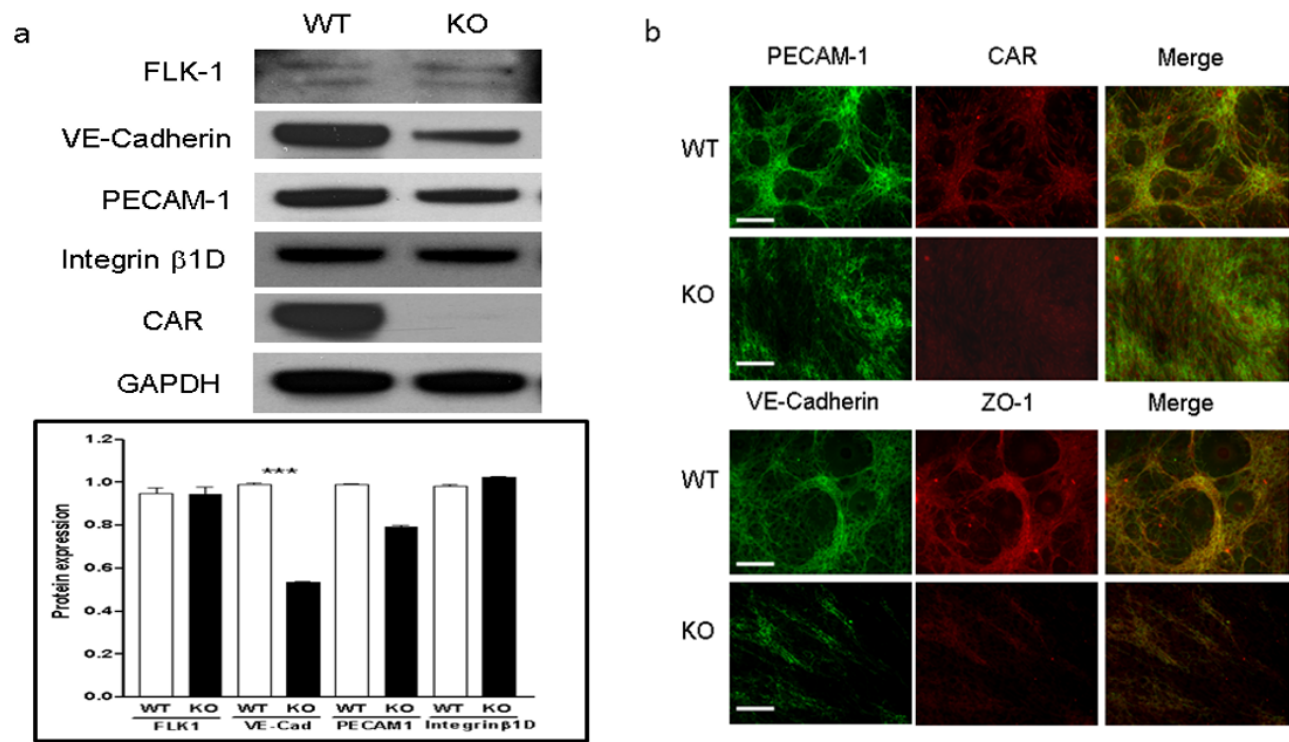
Figure 6. CAR deletion disrupts endothelial cell VE-cadherin and PECAM-1 expression. ( a ). Endothelial cells were isolated from the livers of WT and KO (with deleted CAR) mice. Cell extracts were subjected to Western blot analysis using the indicated antibodies. ( b ). Immunofluorescence staining of endothelial cells to determine changes in cell morphology. All data are the mean ± s.e.m. from 3 independent experiments (scale bar, 60 µm). *** p < 0.001 by two-tailed Student’s t -test.